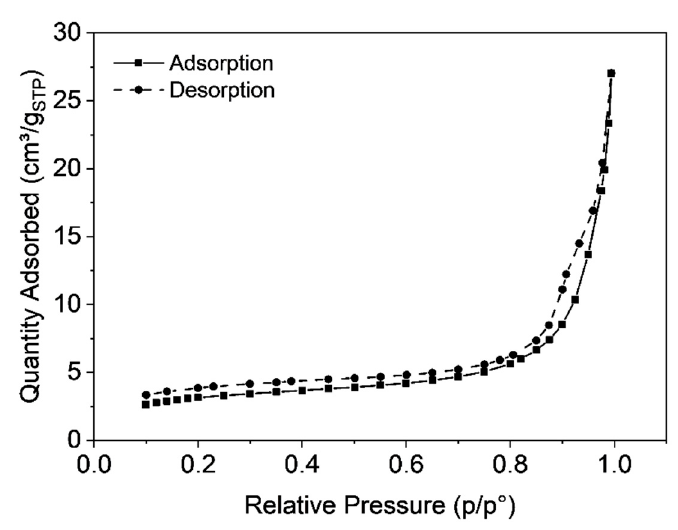
Figure 5. Nitrogen adsorption—desorption cycle giving a TYPE-II isotherm, which is characteristic for macroporous materials. The small hysteresis at higher relative pressures indicates capillary condensation.